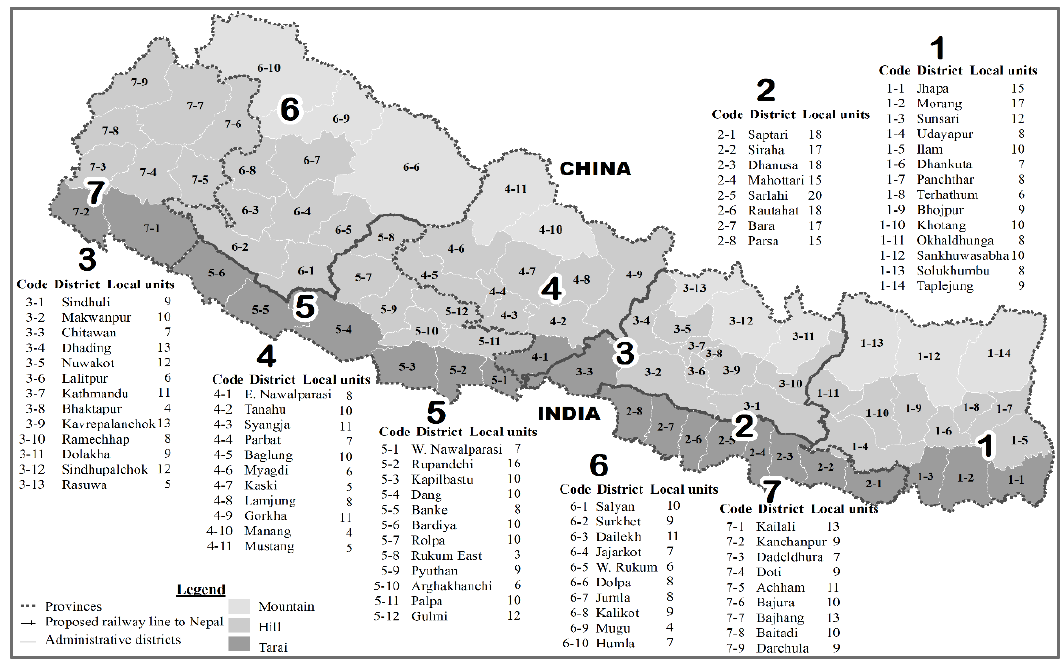
Figure 7. Nepal’s seven federal provinces. Nawalparasi district is split into 2 provinces: East of Bardaghat (Nawalparasi East) is included in Province 4 and west of Bardaghat (Nawalparasi West) is included in Province 5. Likewise, Rukum district is divided into two: East Rukum is included in Province 5 and West Rukum is included in Province 6. Source: [38]:(pp. 169–171).